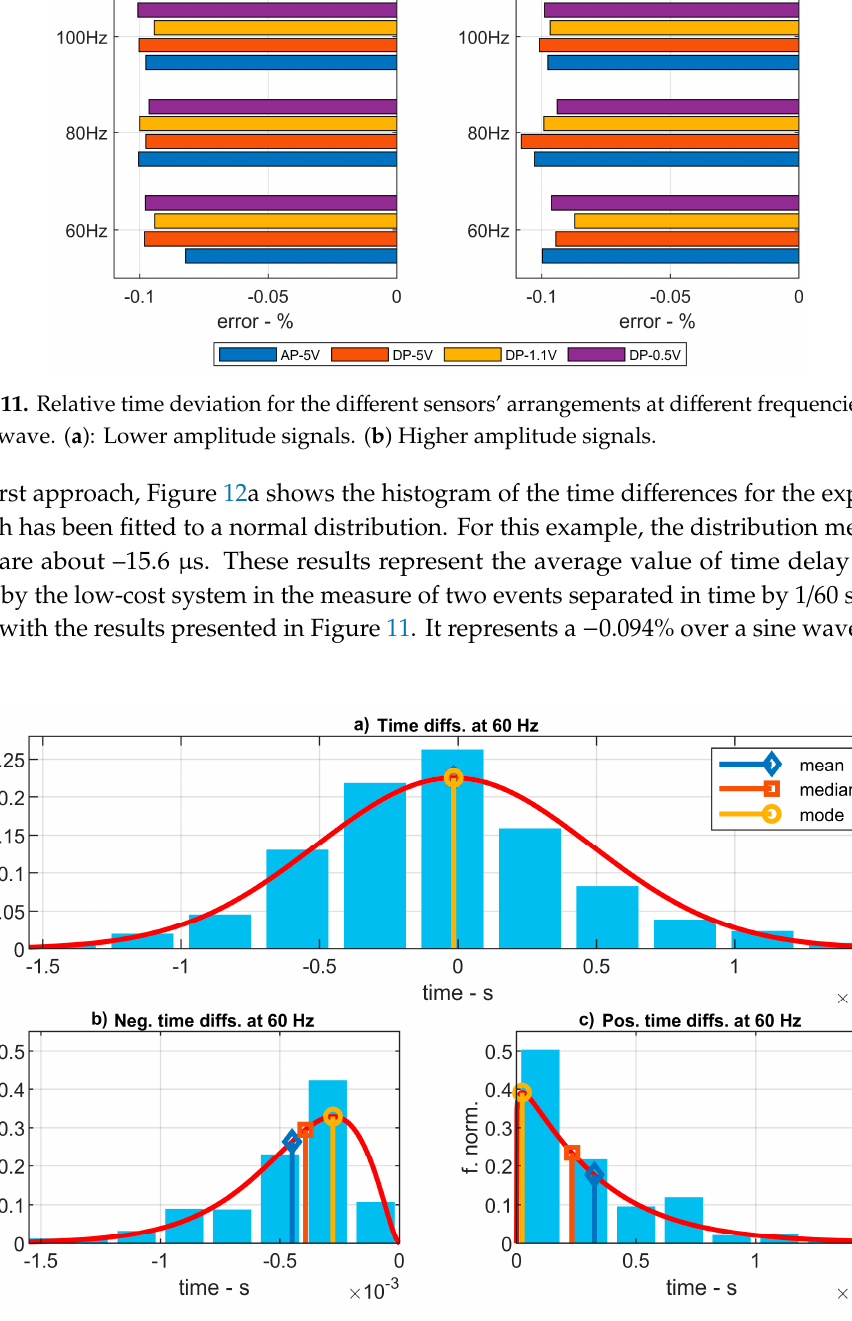
Figure 12. Histogram of the time errors registered for each sound wave’s period at a frequency of 60 Hz. ( a ): Errors are fitted to a normal distribution. ( b , c ): Positive and negative errors are separately fitted to gamma distributions.